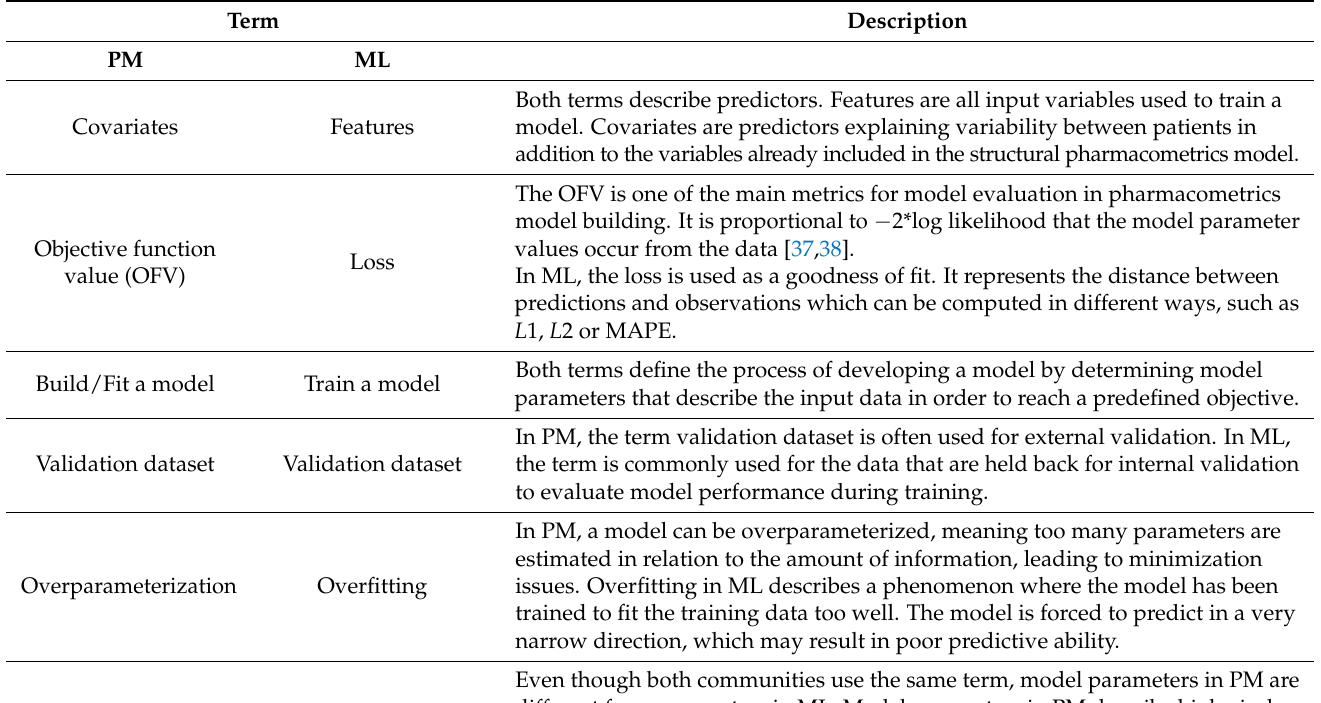
Table 1. Overview of terminology commonly used by the pharmacometrics and/or machine learn- ing